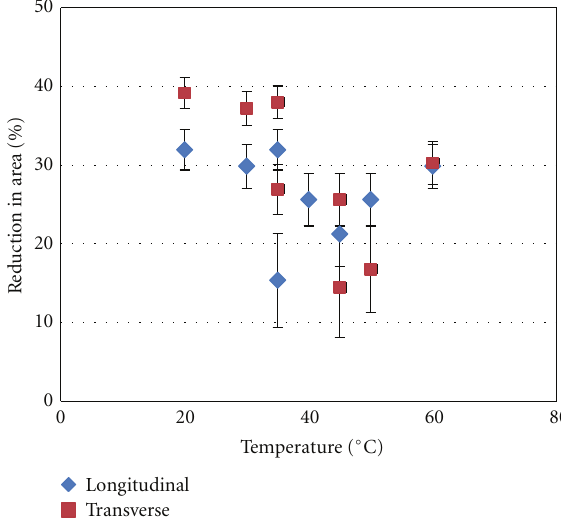
Figure 4: Reduction in area as a function of temperature for specimens machined longitudinal and transverse to the rolling direction, at 800kPa with a gas mixture of 25% CO and 75% CO 2